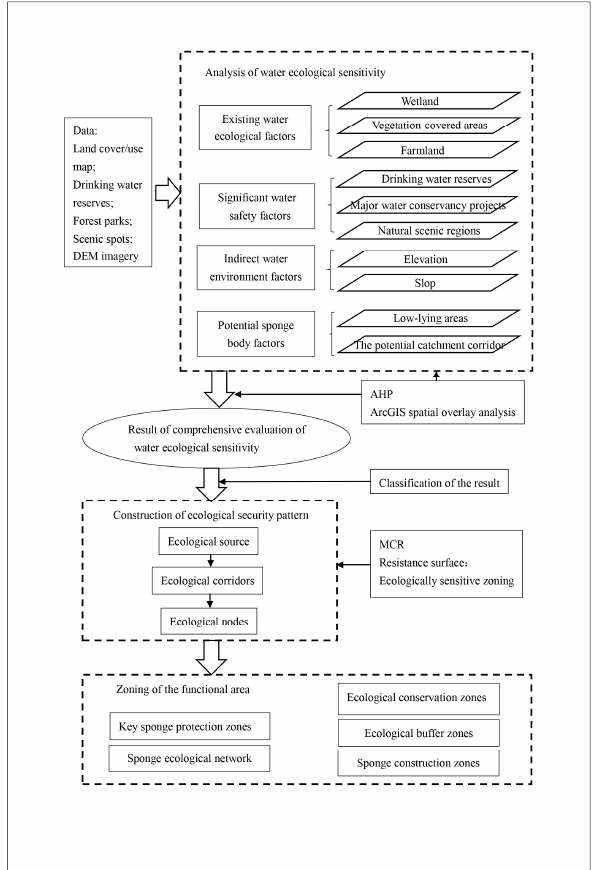
Figure 2. Flowchart for the construction of the ecological security pattern (ESP) for the sponge city.